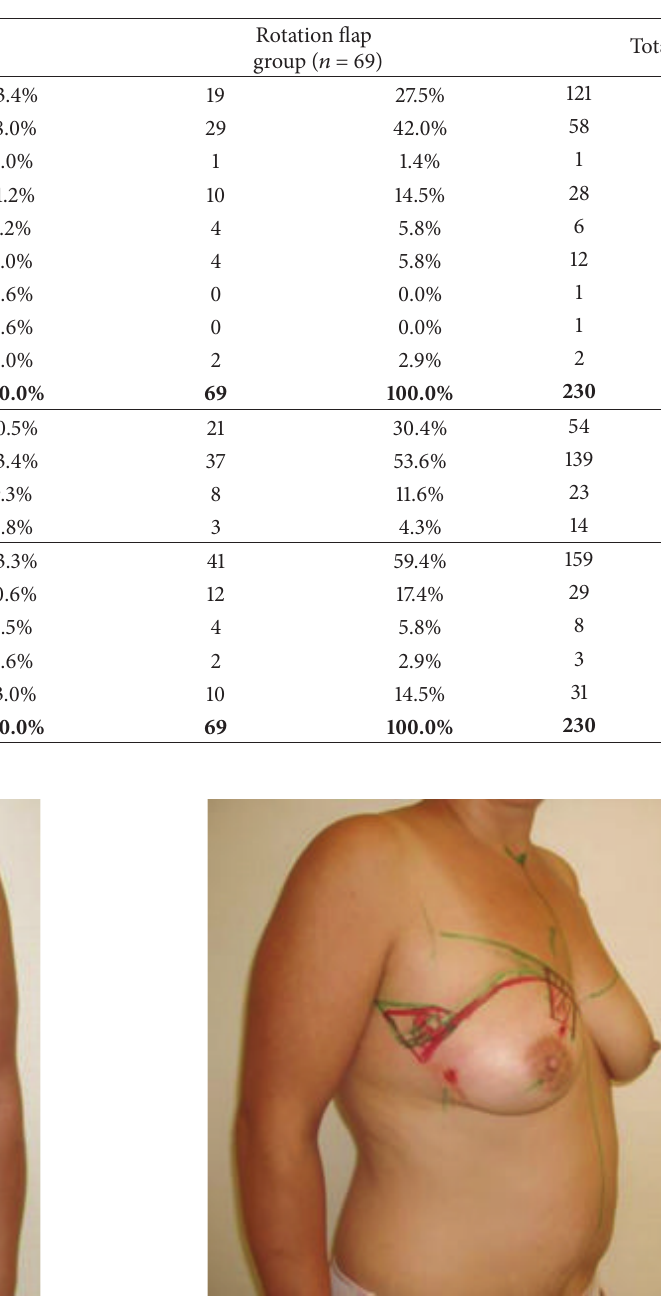
Table 1: Summary of staging and axillary intervention.